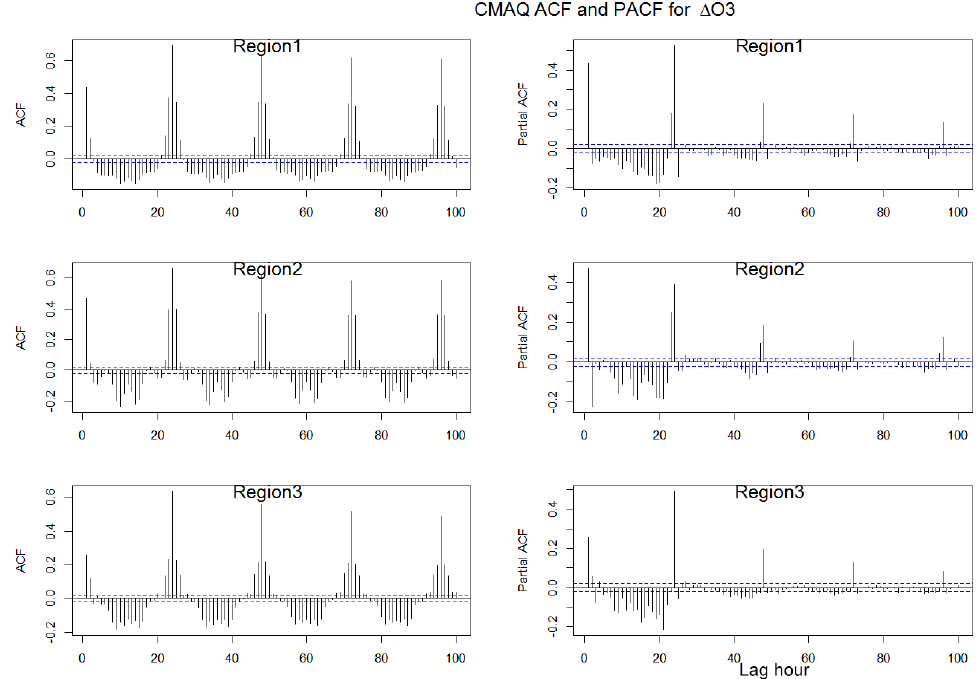
Figure 20. CMAQ model: autocorrelation (ACF) and partial autocorrelation (PACF) functions for the differenced time series of residuals of ozone (model–observations). The differentiation is necessary to remove non-stationarity and thus to convey the ACF and PACF values depending on lag only.